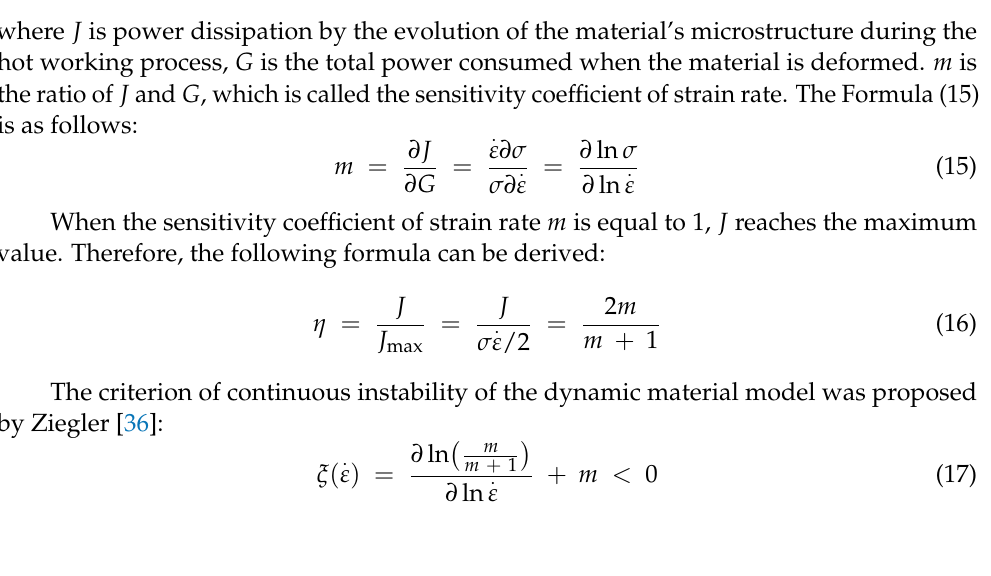
Figure 15. Simulation of cylindrical sample (Ø 8 × 12 mm): ( a ) the distribution of strain at 1100 °C/0.1 s −1 with adaptive simulated annealing optimization method; ( b ) the distribution of strain at 1100 °C/0.1 s −1 with the traditional calibration method; ( c ) force vs. displacement plot of experimental and predicted values (Hansel–Spittel model of two methods) at 1100 °C/0.1 s −1 .